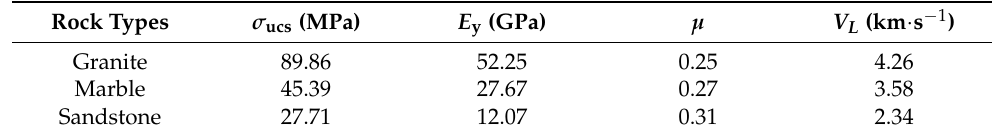
Table 2. Basic mechanical parameters of granite, marble, and sandstone.